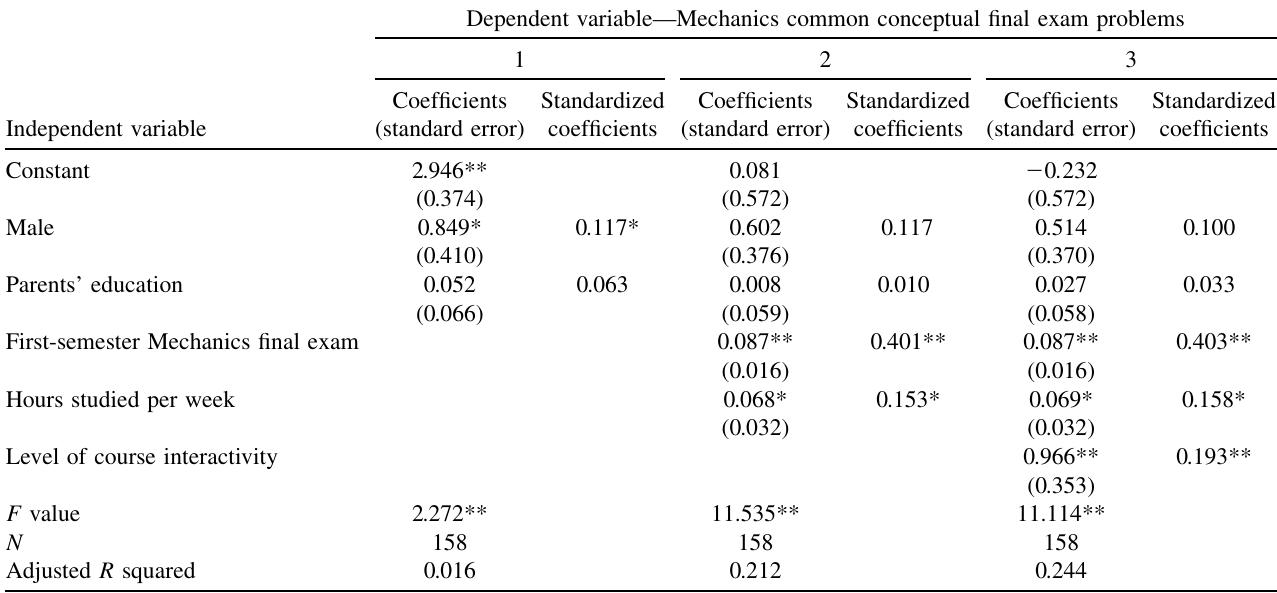
TABLE V. Mechanics common final exam—Models 1–3 (* p < 0 : 05 , ** p < 0 : 01 ). Dependent variable—Mechanics common conceptual final exam